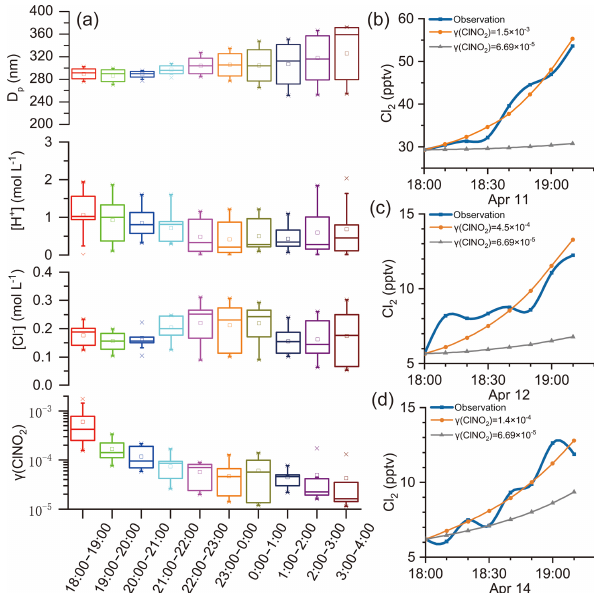
Figure 6. γ (ClNO 2 ) estimated using field observation data. (a) γ (ClNO 2 ) obs , [Cl − ], [H + ], and D p estimated at various nighttime periods. (b) – (d) Trends of increasing trends of Cl 2 mixing ratios during the early evening hours on 11, 12, and 14 April, respectively. Orange and grey lines represent the projected trend of Cl 2 mixing ratios using Eq. (12) with constant γ (ClNO 2 ) values and observed ClNO 2